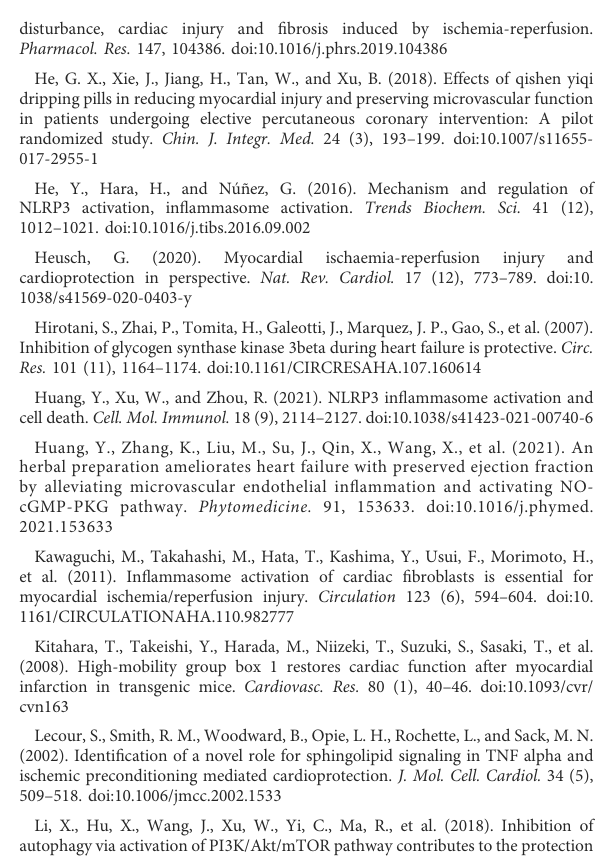
SUPPLEMENTARY TABLE S1 Metabolite and potential targets of QSYQ. After the preliminary pharmacokinetic screening, a total of 111 metabolite components (20 in Huangqi, 65 in Danshen, 1 in Sanqi , and 33 in Jiangxiang), and 477 targets were obtained. SUPPLEMENTARY TABLE S2 Myocardial I/R injury-related targets. By searching the TTD